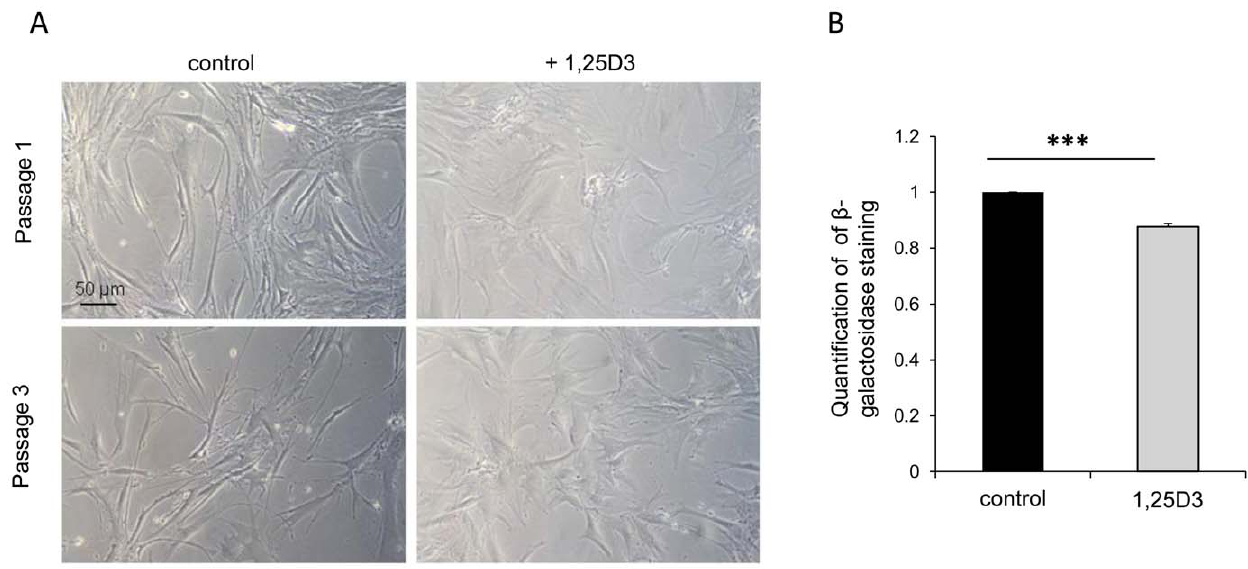
Figure 3. Morphological characteristics of 1,25D3 cultured hMSC and ß-galactosidase quantification. A Morphology of hMSC in P1 (upper row) and P3 (lower row) treated with 1,25D3 over three passages compared to control cells. 1,25D3 incubated hMSC lost their typical fibroblast-like features and showed a broadened and extended cellular morphology. Scale bar=50 m m. B The induction of ß-galactosidase was significantly reduced in 1,25D3 cultured cells compared to control hMSC. Cells from three different donors were used and were cultured up to three passages. The results are shown as mean + SEM of three independent experiments, each normalized to its control. Each time five pictures of ß- galactosidase staining were analyzed using the AutMess tool of AxioVision Rel. 4.6 software. (***, p , 0.001, student’s t-test).